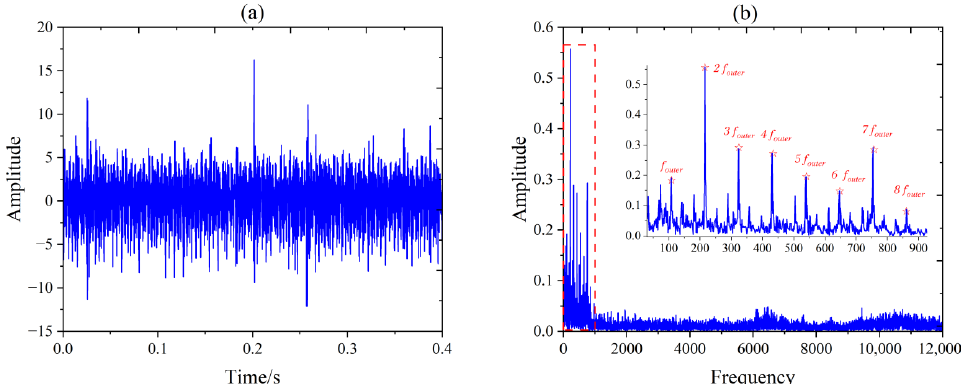
Figure 13. ( a ) The 2100 r/min outer race fault signal and ( b ) its envelope spectrum.